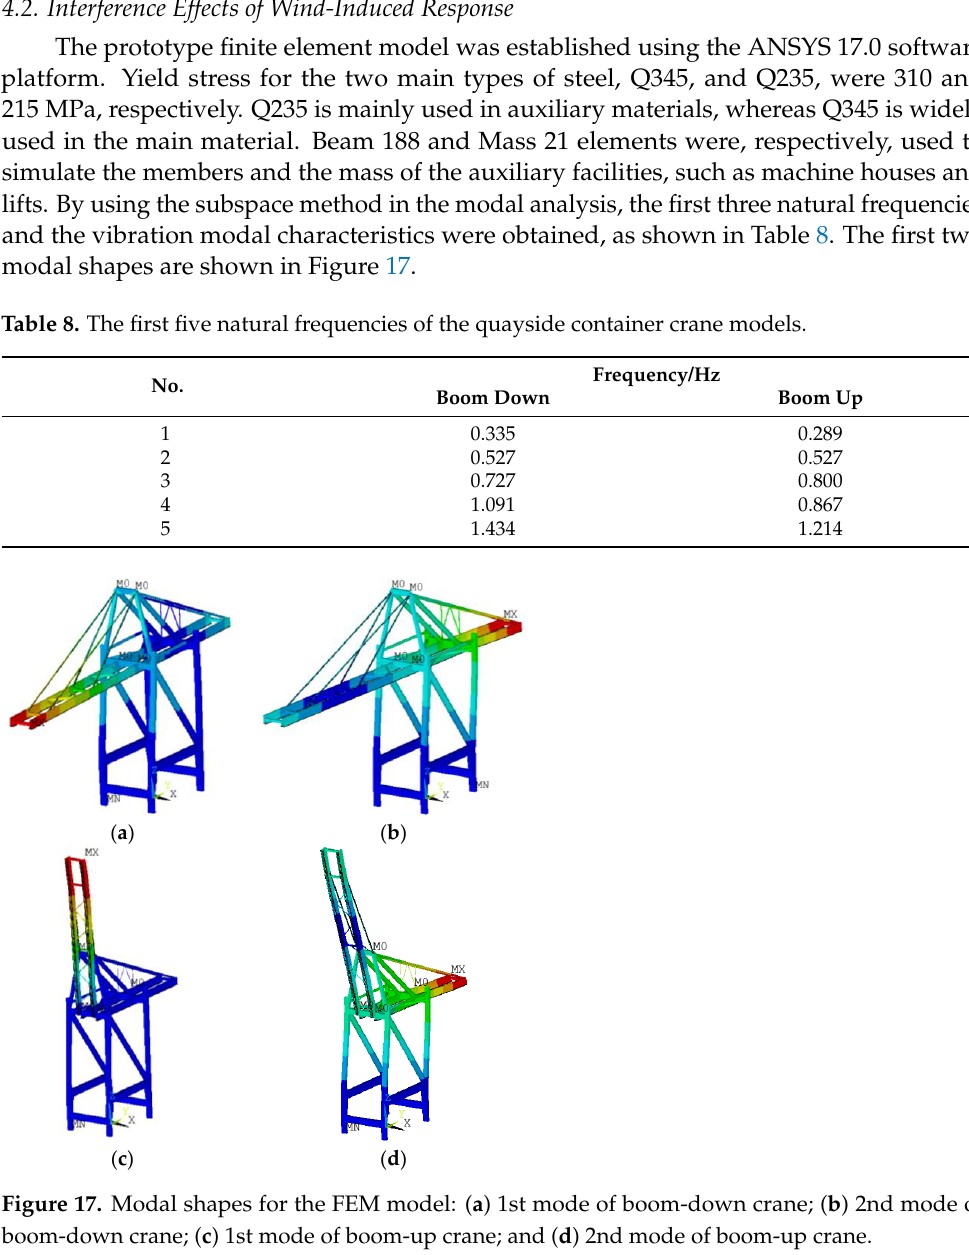
Figure 16. Contour plots of the horizontal wind velocity at the height of the jib of the boom-up crane (h = 57m): ( a ) α = 30°; and ( b ) α = 90°.